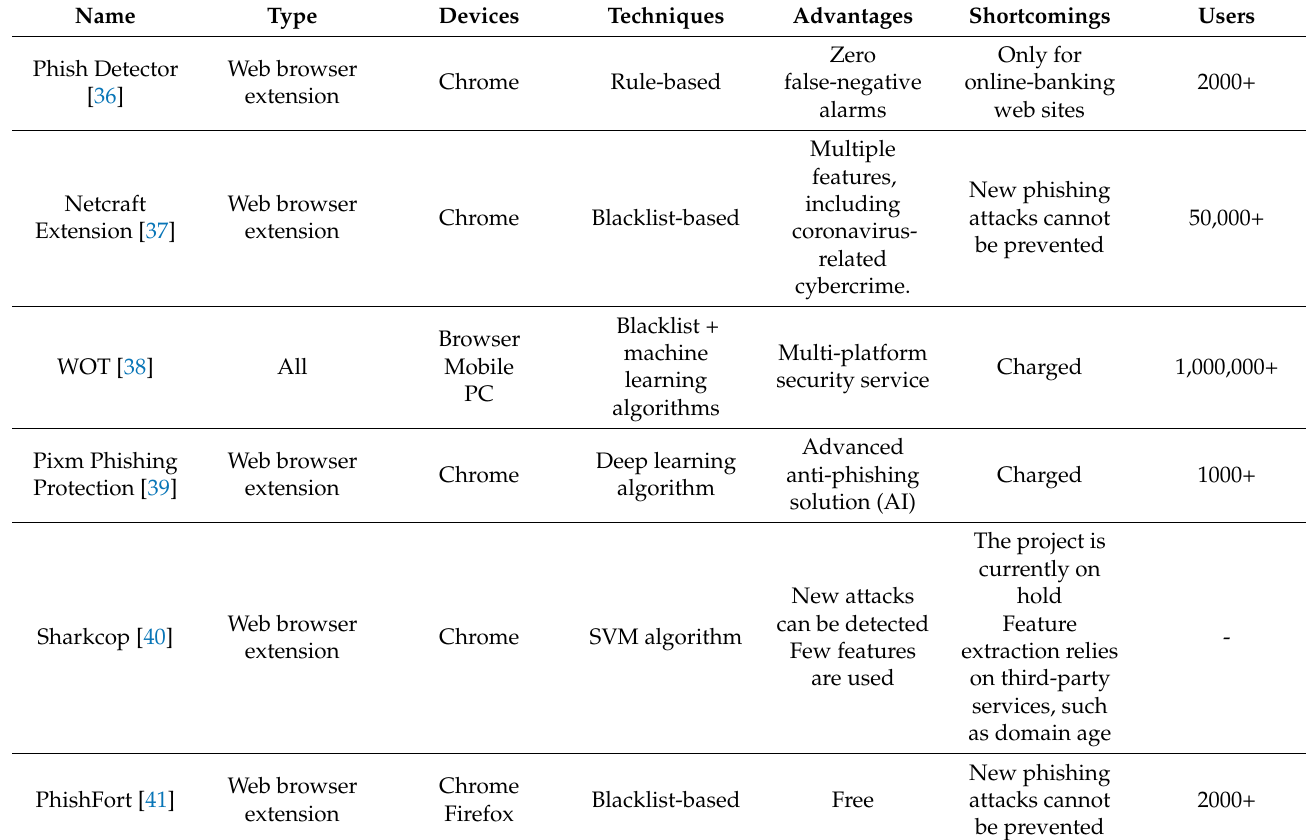
Table 4. Released phishing detection